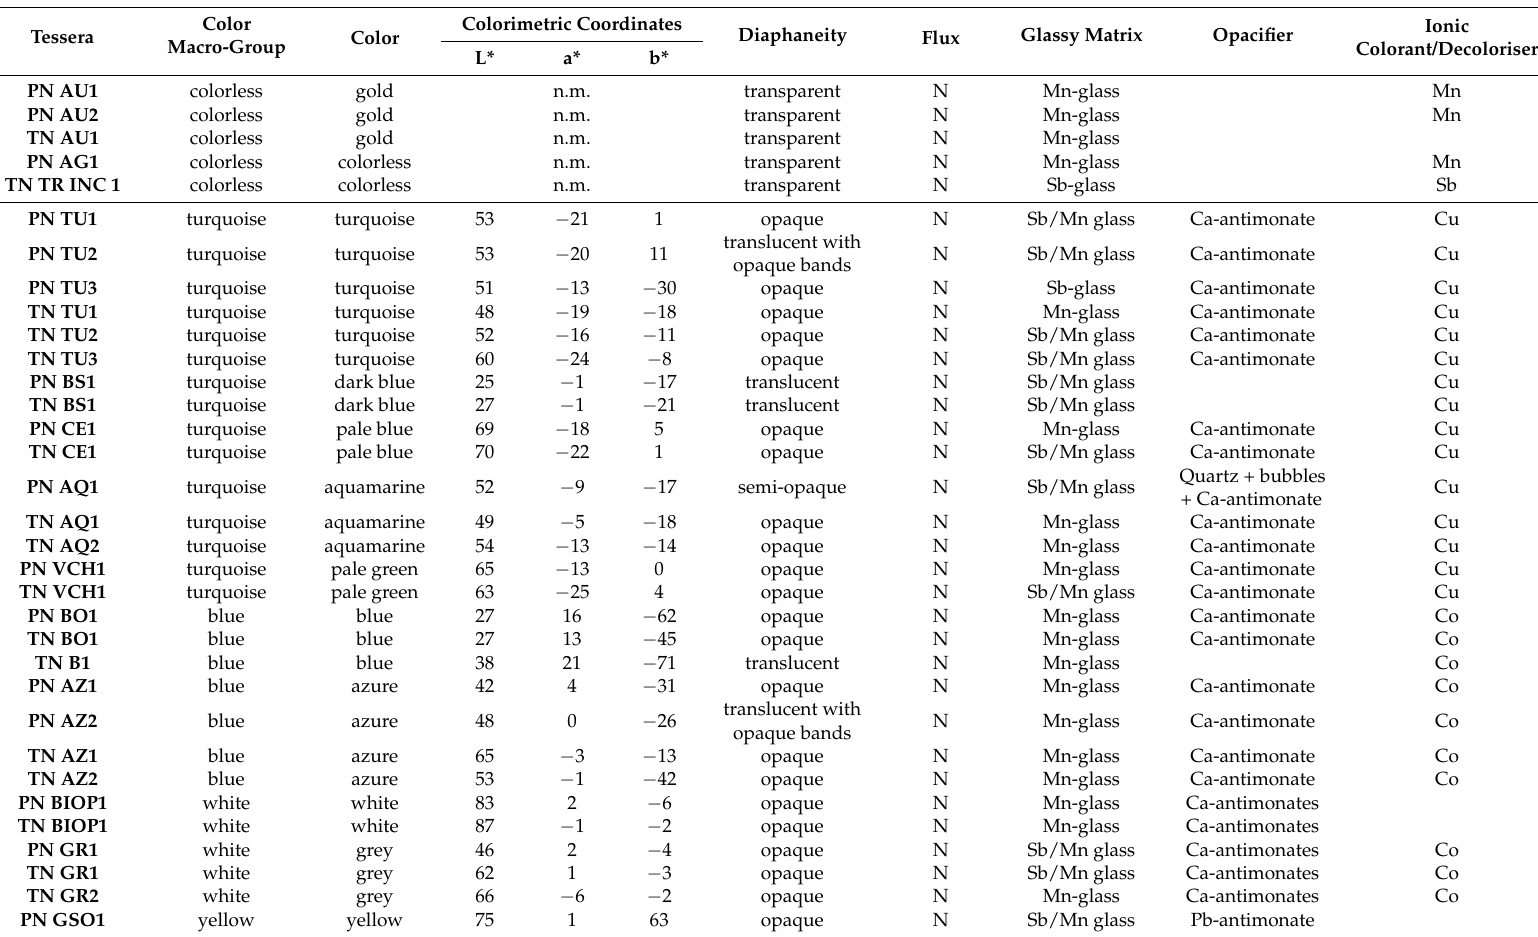
Table 1. A list of glass tesserae from Pordenone (PN) and Trento (TN), subdivided by color macro-group. Colorimetric coordinates and a summary of the major textural and chemical characteristics of each tessera are also reported. (N = natron; A = soda ash; n.m.: not measured; n.a.: not attributed).